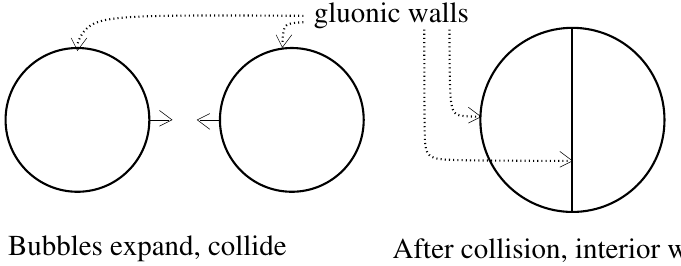
Figure 8. Bubbles collide producing a bubble with a guonic wall.